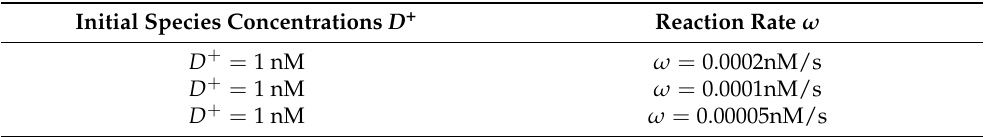
Table 6. The initial species concentrations and reaction rate ω